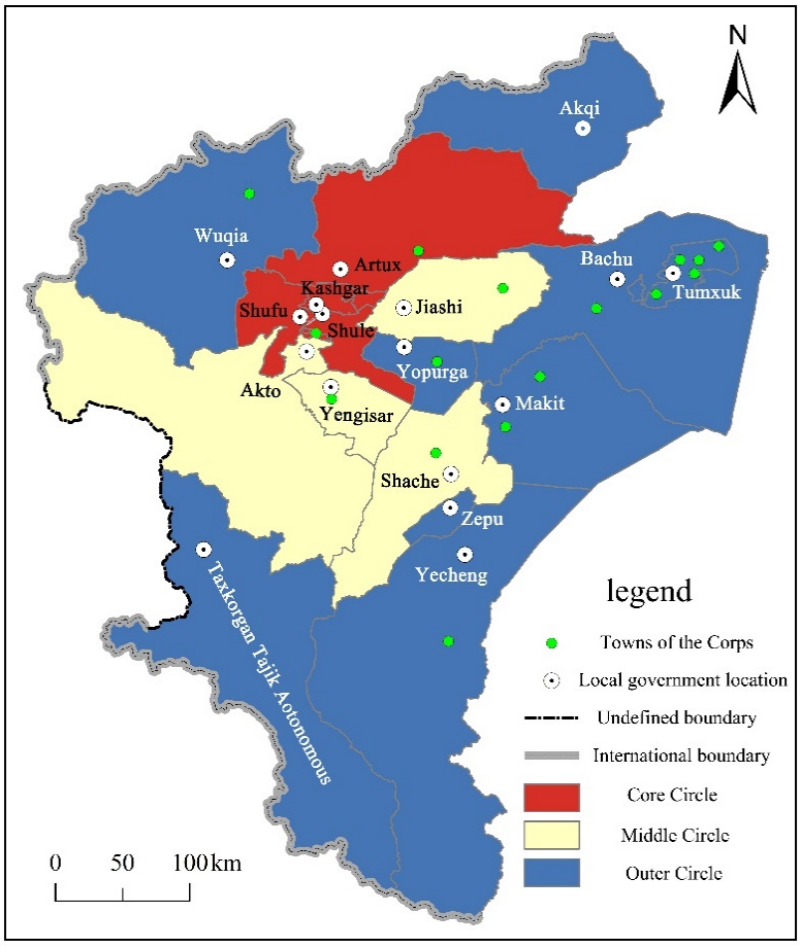
Figure 10. A map of three types of circle scope in the KMA.